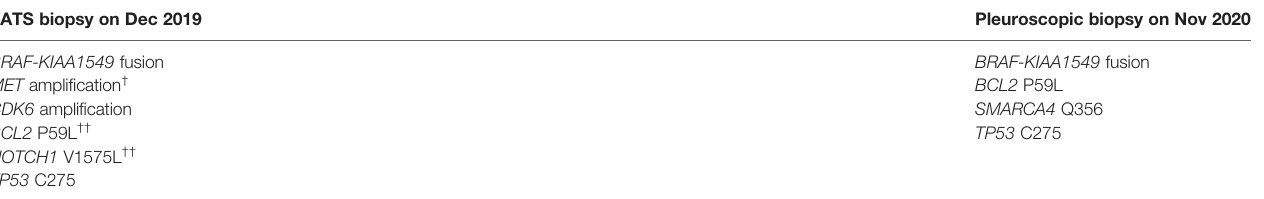
FIGURE 1 | Next-generation sequencing of the tissue specimen from the video-assisted thoracic surgery biopsy of right middle lung cancer revealed a BRAF- KIAA1549 fusion. The data was provided by the Department of Research and Development, Foundation Medicine Inc. TABLE 1 | The detailed genomic alterations of the repeated biopsy specimen detected by FoundationOne